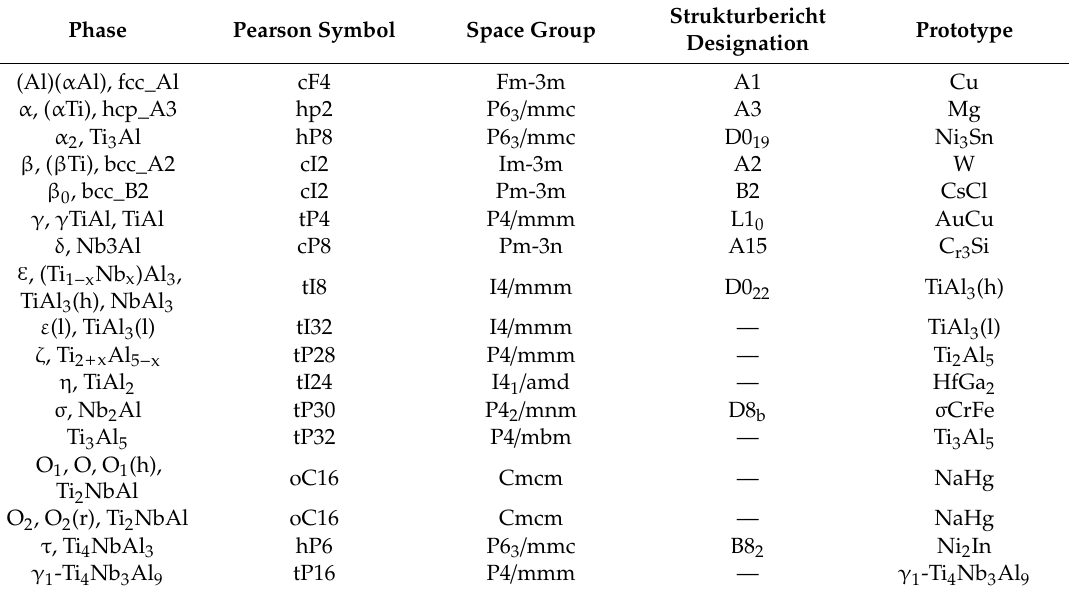
Table 1. Crystal structure data of di ff erent phases in Ti-Al-Nb